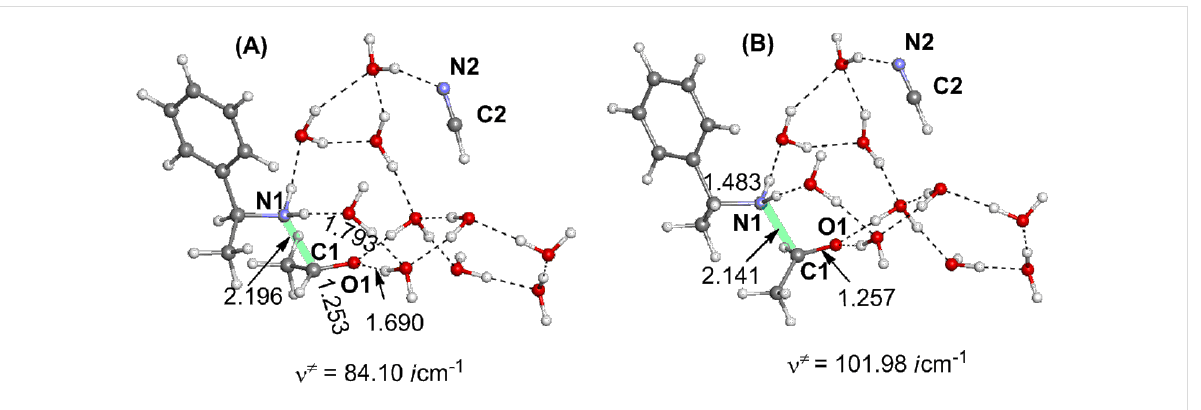
Figure S3 in Supporting Information File 1 for the geometry of 8 . Our proposed pathways are shown in Scheme 8.